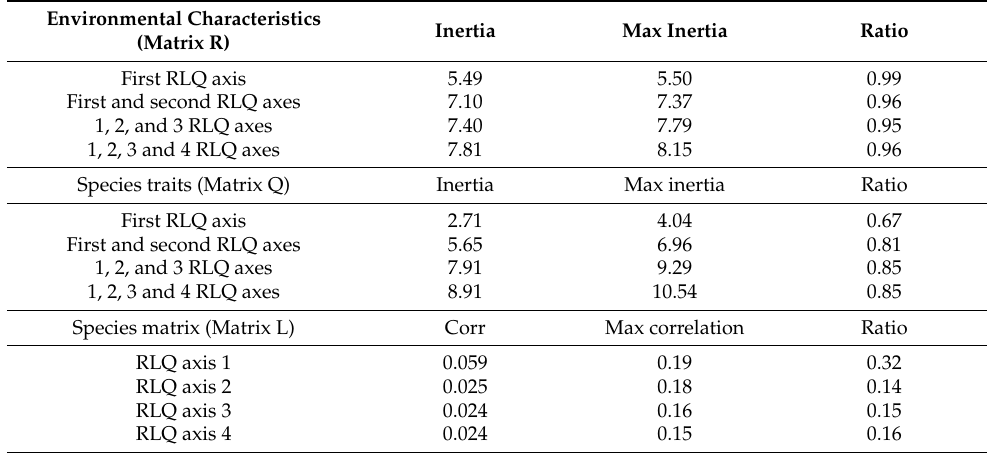
Table A5. Comparison of RLQ analysis results with ordinal multivariate data matrix analysis